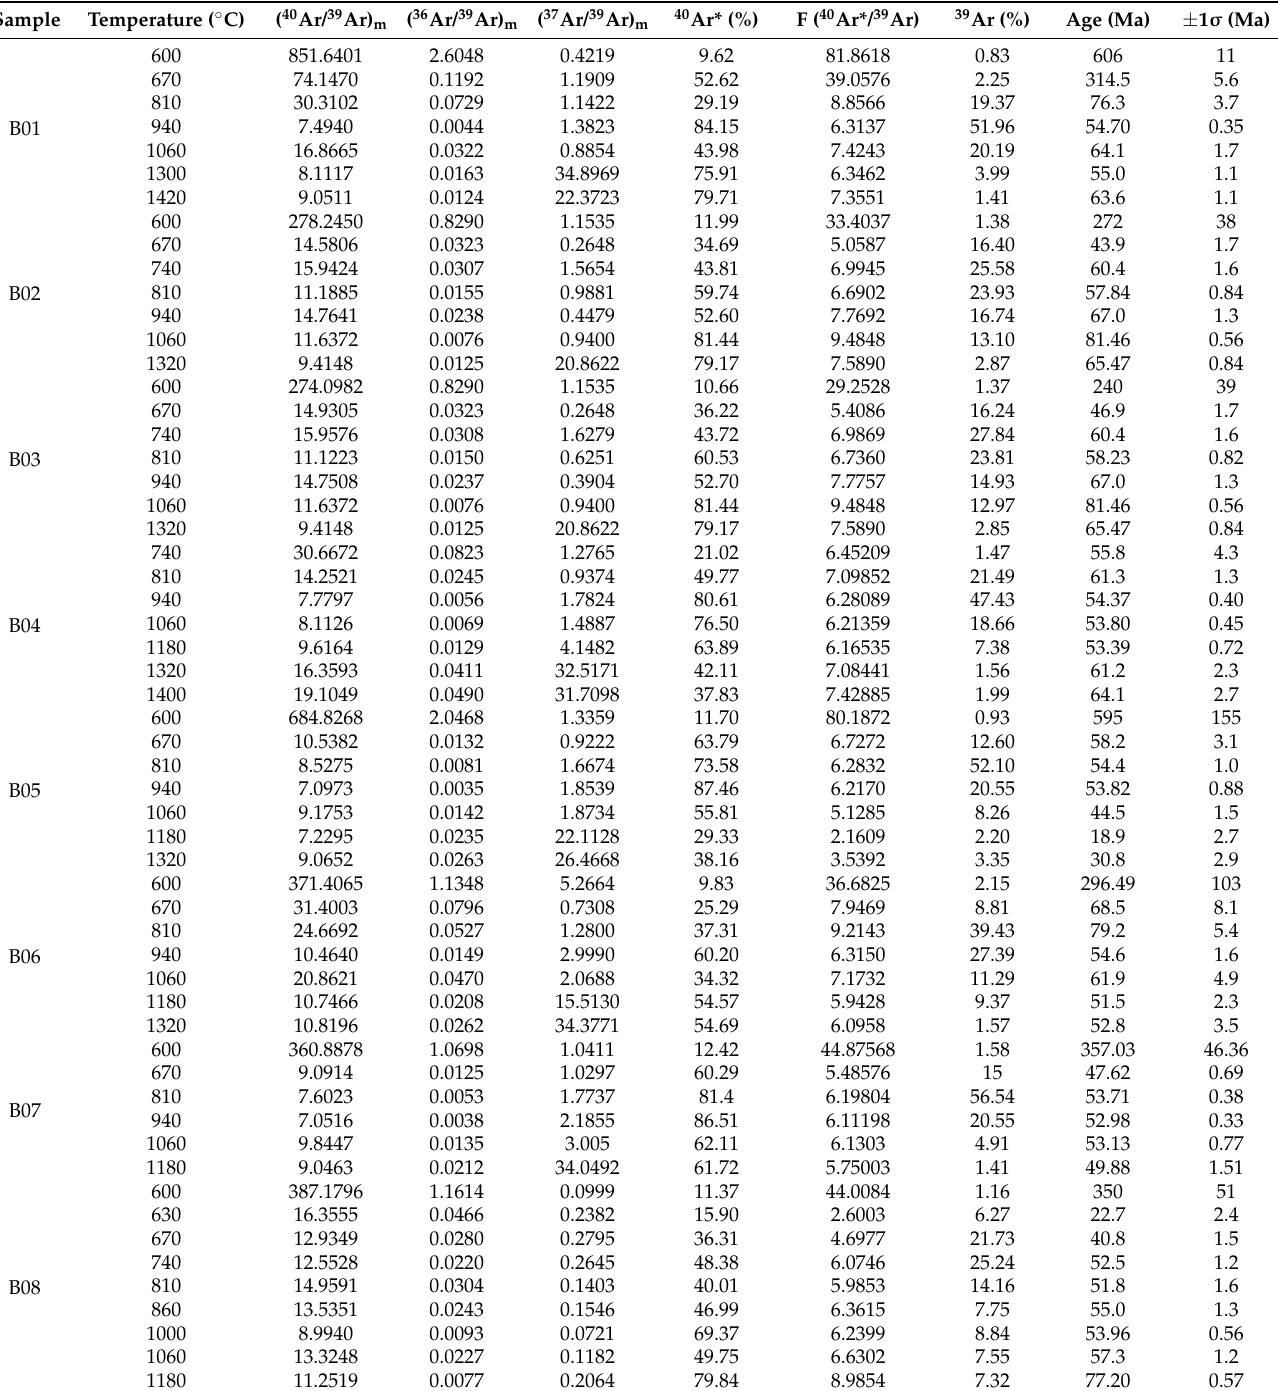
Table 2. 40 Ar/ 39 Ar isotopic analytical data of the incremental heating experiments on basaltic